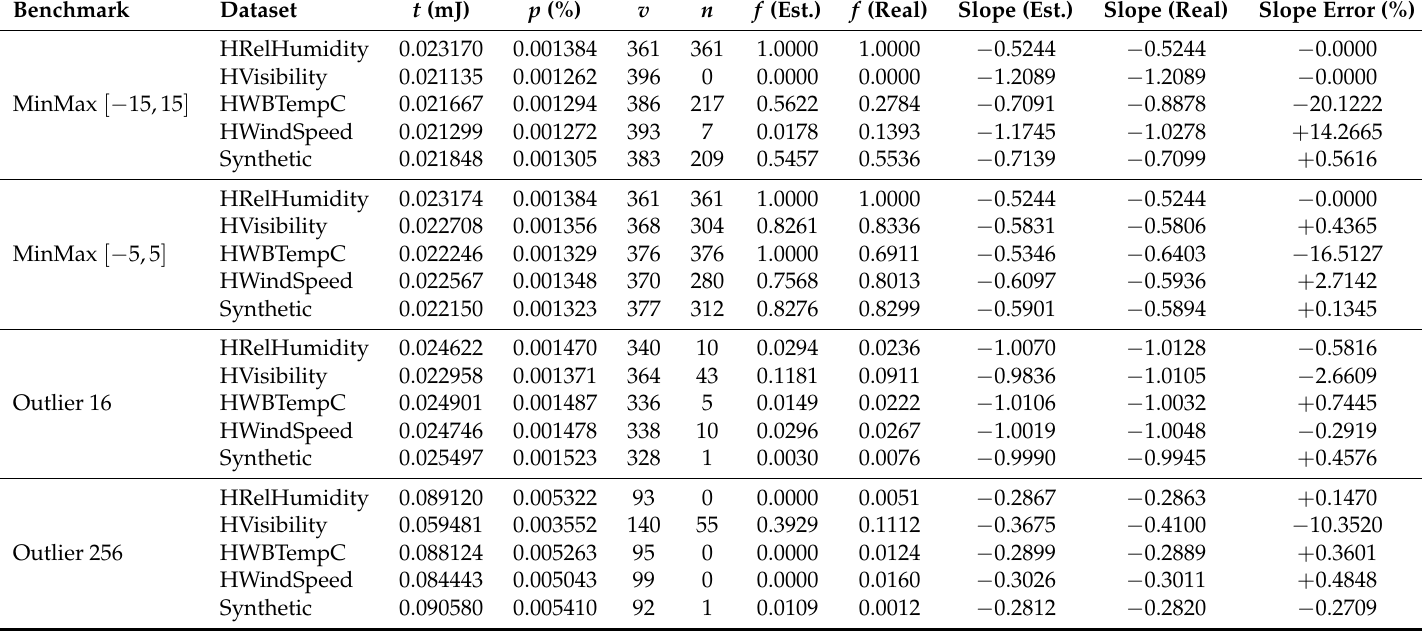
Table A5. NodeMCU energy consumption results in cloud-prone